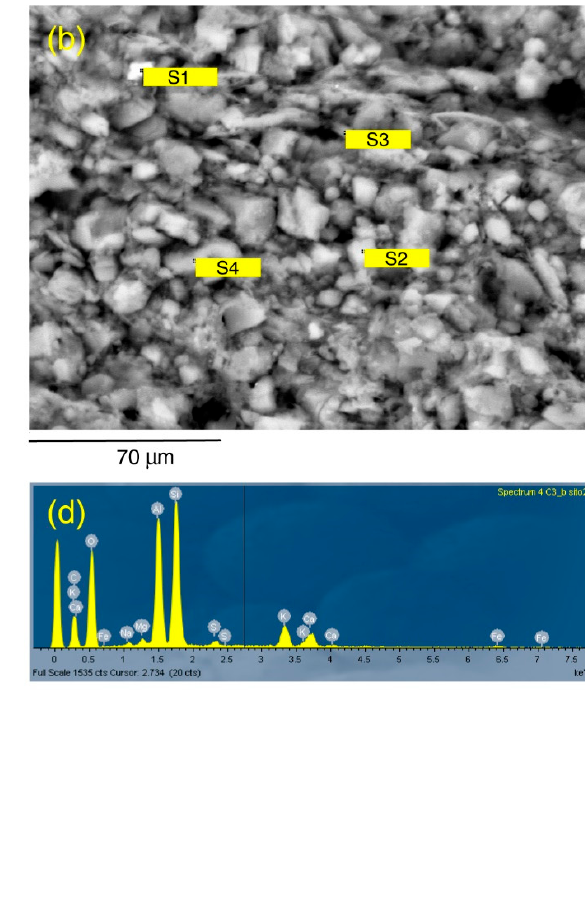
Table 5. Semi-quantitative analysis of C3 sample in atoms percentage.